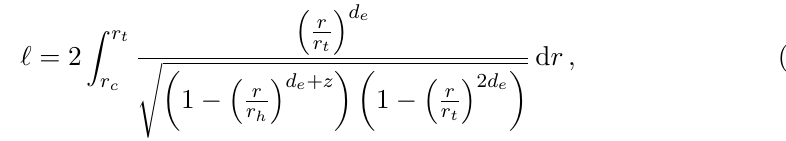
. r is i =2 ,...,d c the black hole h